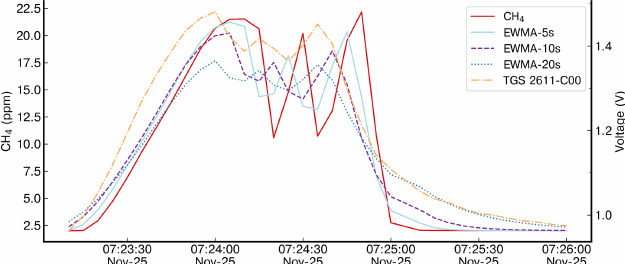
Figure A1. Different time constant values of the exponential weighted moving average (EWMA) applied to the reference instrument. The reference instrument is shown by dotted red lines. The applied smoothing for three values of time constant (5, 10 and 20s) is denoted “EWMA” for one peak and the TGS 2611-C00 voltage from logger A to compare the smoothing effect shown by the dotted yellow lines.